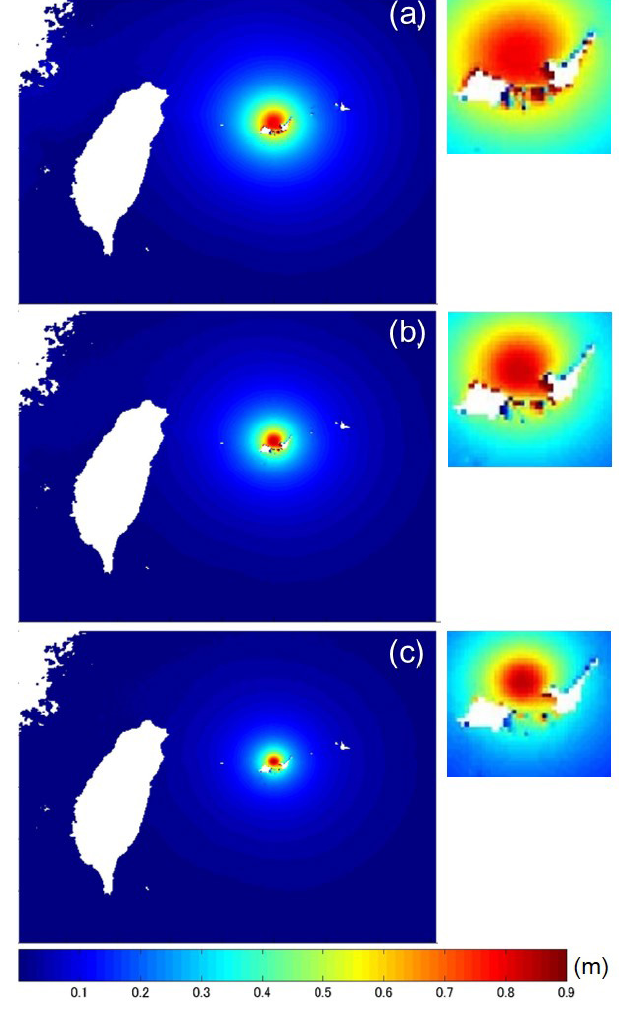
Figure 8. Distribution of storm surge heights at the time of Ty- phoon Goni passed over Ishigaki-jima, estimated with R max derived from (a) 0.35 R 50 , (b) 0.23 R 50 , and (c) 0.15 R 50